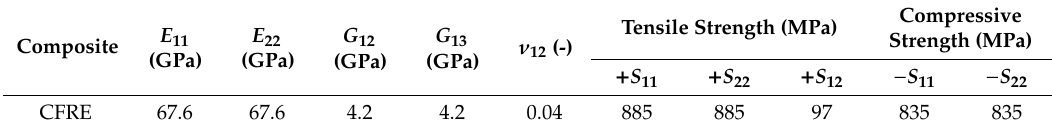
Table 1. Mechanical properties of the carbon fiber reinforce epoxy (CFRE) lamina, as provided by the manufacturer (Composites Ate, S.L., Barcelona, Spain).